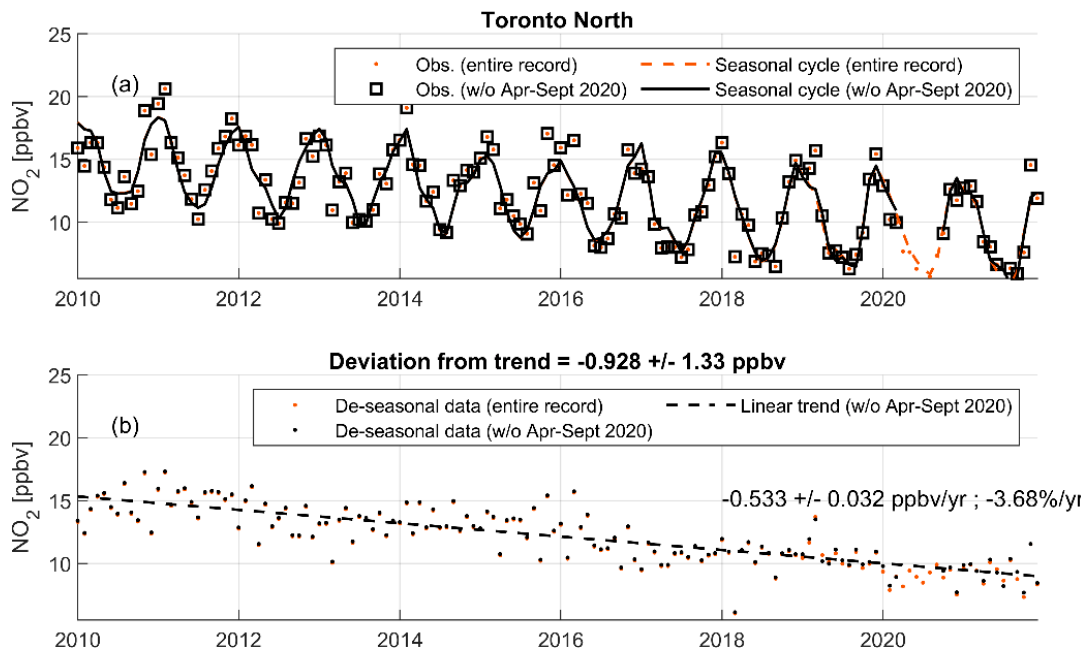
Figure A1. Surface NO 2 trend fitting results from the statistical model at the Toronto North site. Red symbols represent data and fittings for the entire observation record. Black symbols represent data and fittings for the records without data from April to September 2020. Panel ( a ) shows the observations and fitted seasonal cycles; panel ( b ) shows the de-seasonal data and fitted linear trend.